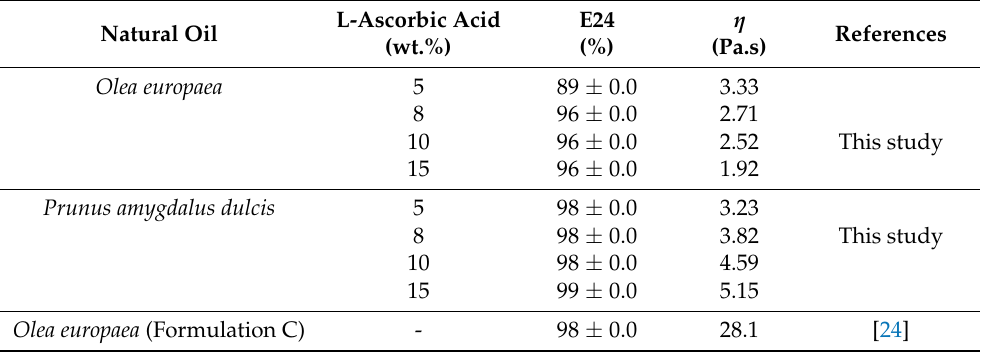
Figure 1. FucoPol-based emulsions prepared with Olea europaea fruit oil (( upper ) images) and Prunus amygdalus dulcis oil (( lower ) images), supplemented with different L-ascorbic acid concentrations: ( a ), 5.0 wt.%; ( b ), 8.0 wt.%; ( c ), 10 wt.%; ( d ), 15 wt.%. Table 2. pH, conductivity, E24, and apparent viscosity ( η , measured at 2.30 s − 1 ) for the emulsified formulations containing different L-ascorbic acid concentrations. Data obtained under the same manufacturing and scale conditions.